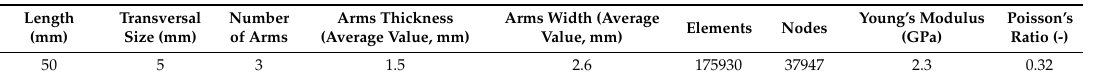
Figure 8. Cell radial displacement ( left ) and axial force ( right ) versus axial displacement. A stress analysis was finally performed to verify the cell integrity in the most severe assigned conditions (2 mm max radial displacement, Figure 8, left) and highlight the most critical zones. A Von Mises strain map is shown in Figure 9; some local maxima are evident at the middle of the arms. Other ones are visible at the extremities; in that case, however, constraints and applied forces effects are clearly present. Strain reached about 1.85% (18,500 µ ε ), corresponding to about 42.5 MPa stress. This value was well below the ABS ultimate strength (66.7 MPa).